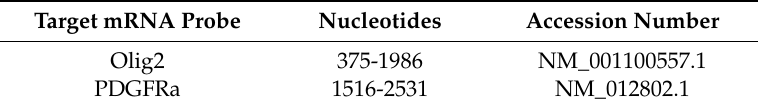
Table 3. List of RNAscope ®